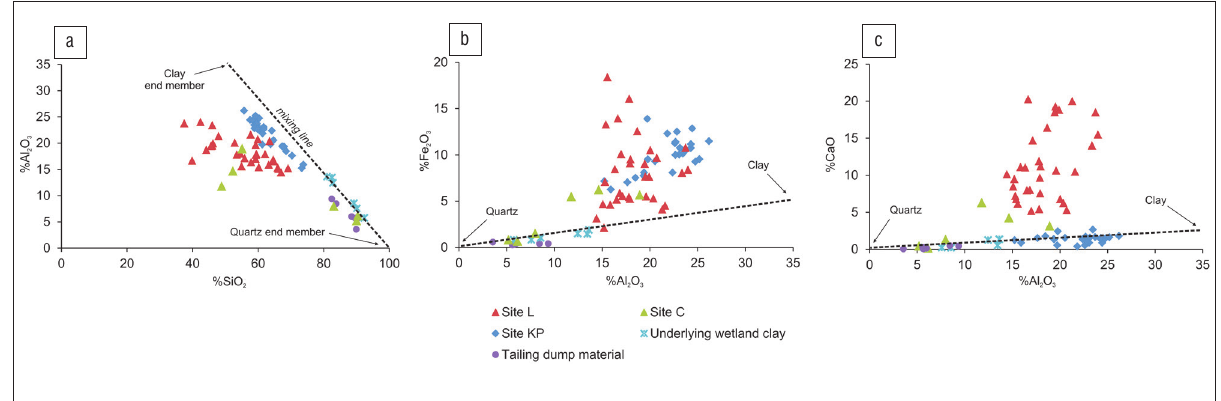
and Al O , (b) Al O and Fe O and (c) Al O and CaO in the underlying wetland clay, tailings storage facilities material, 2 2 3 2 3 2 3 2 3